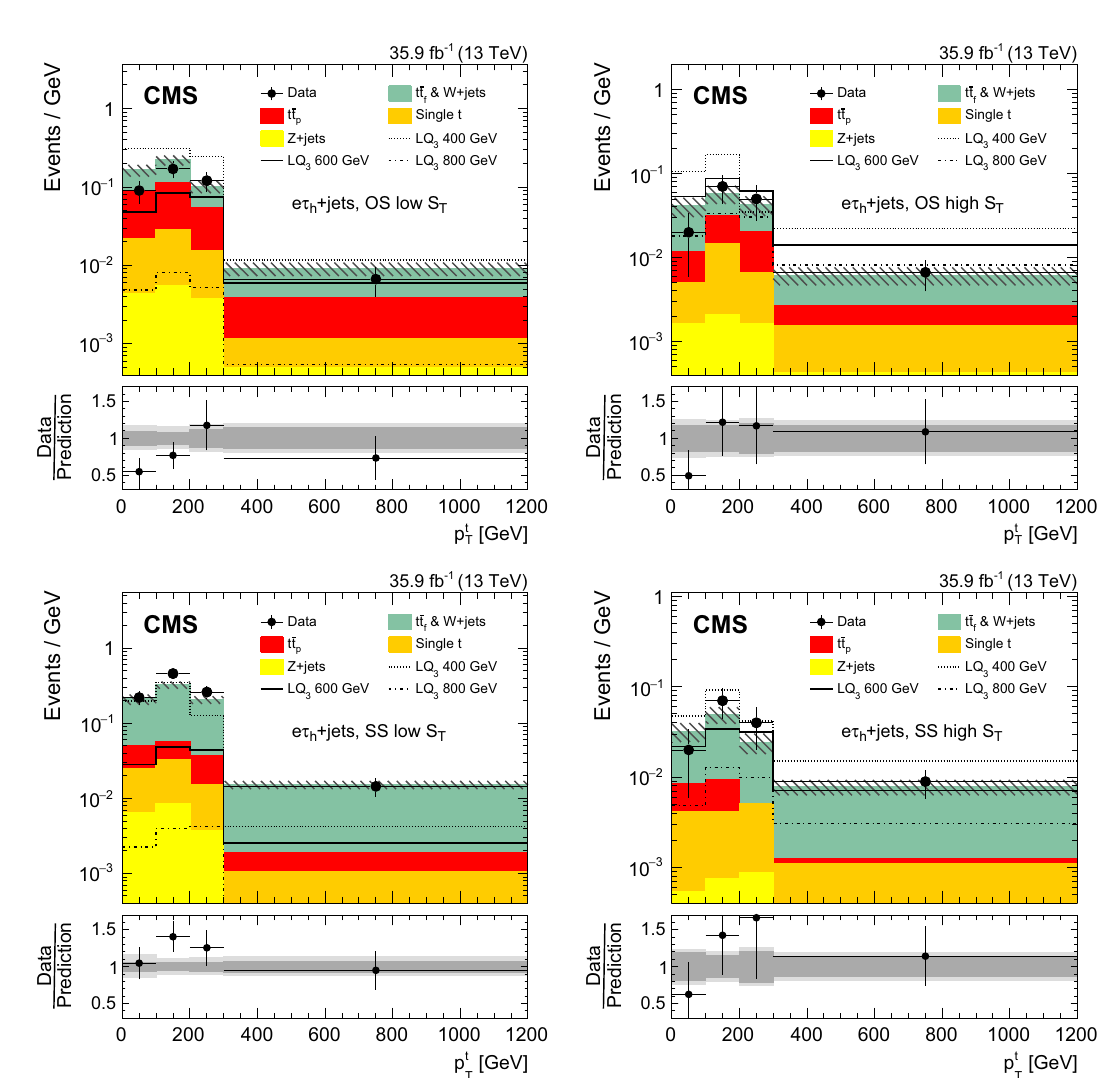
Fig. 4 Distributionsof p t foreventsintheelectronchannelpassingthe T full selection in category A. The events are separated into OS (upper), SS (lower), low S T (left) and high S T (right) categories. The hatched areas represent the total uncertainties of the SM background. In the bot-